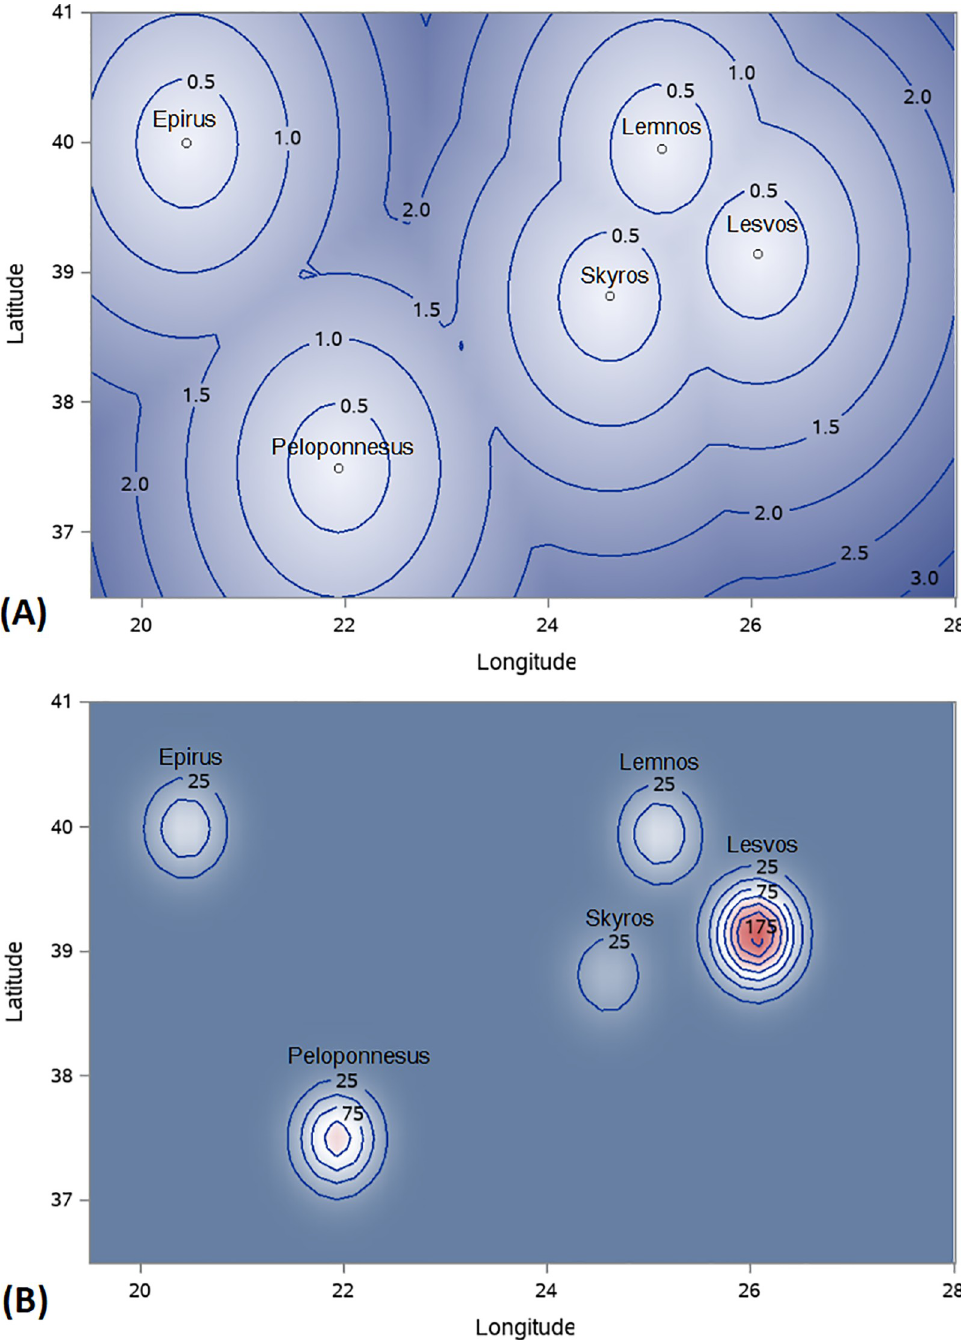
Fig 2. Plots of the mean nearest neighbor distances (A) and Gaussian kernel smoothed intensity (B) of animals’ genomic relationships along the geographical landscape. The plots indicate that animals sampled from the same location have higher genetic similarity than distantly placed or randomly selected